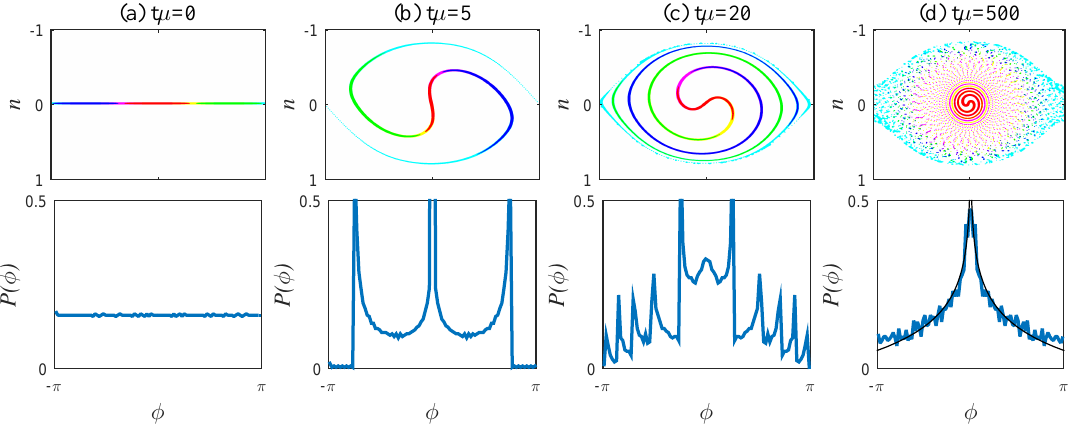
Figure 1: Upper panel: Phase-space representation of the time evolution of Eq. 5 with J /µ = 0.2. Each plot represents the dynamics of 4000 points with initial conditions n ( t = 0 ) = 0 and φ ( t = 0 ) uniformly distributed between − π and π . Each pixel is colored according to the corresponding value of φ ( t = 0 ) . (a) The initial state is | n = 0 〉 and corresponds to a thin horizontal line in phase space. (b-d) Time snapshots of the evolution of the quantum ensemble. Lower panel: Time evolution of the marginal probability distribution P ( φ ( t )) . At long